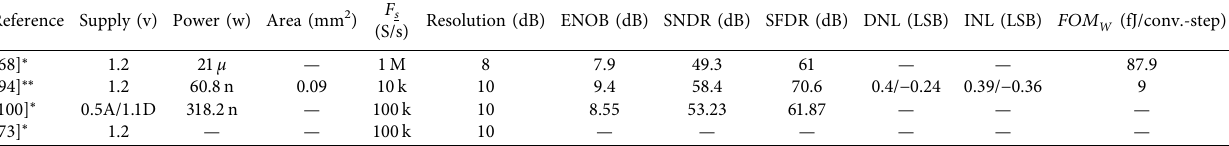
Table 7: Summary of the recently published SAR ADC performance parameters in 65nm process. Reference Supply (v) Power (w) Area (mm 2 )